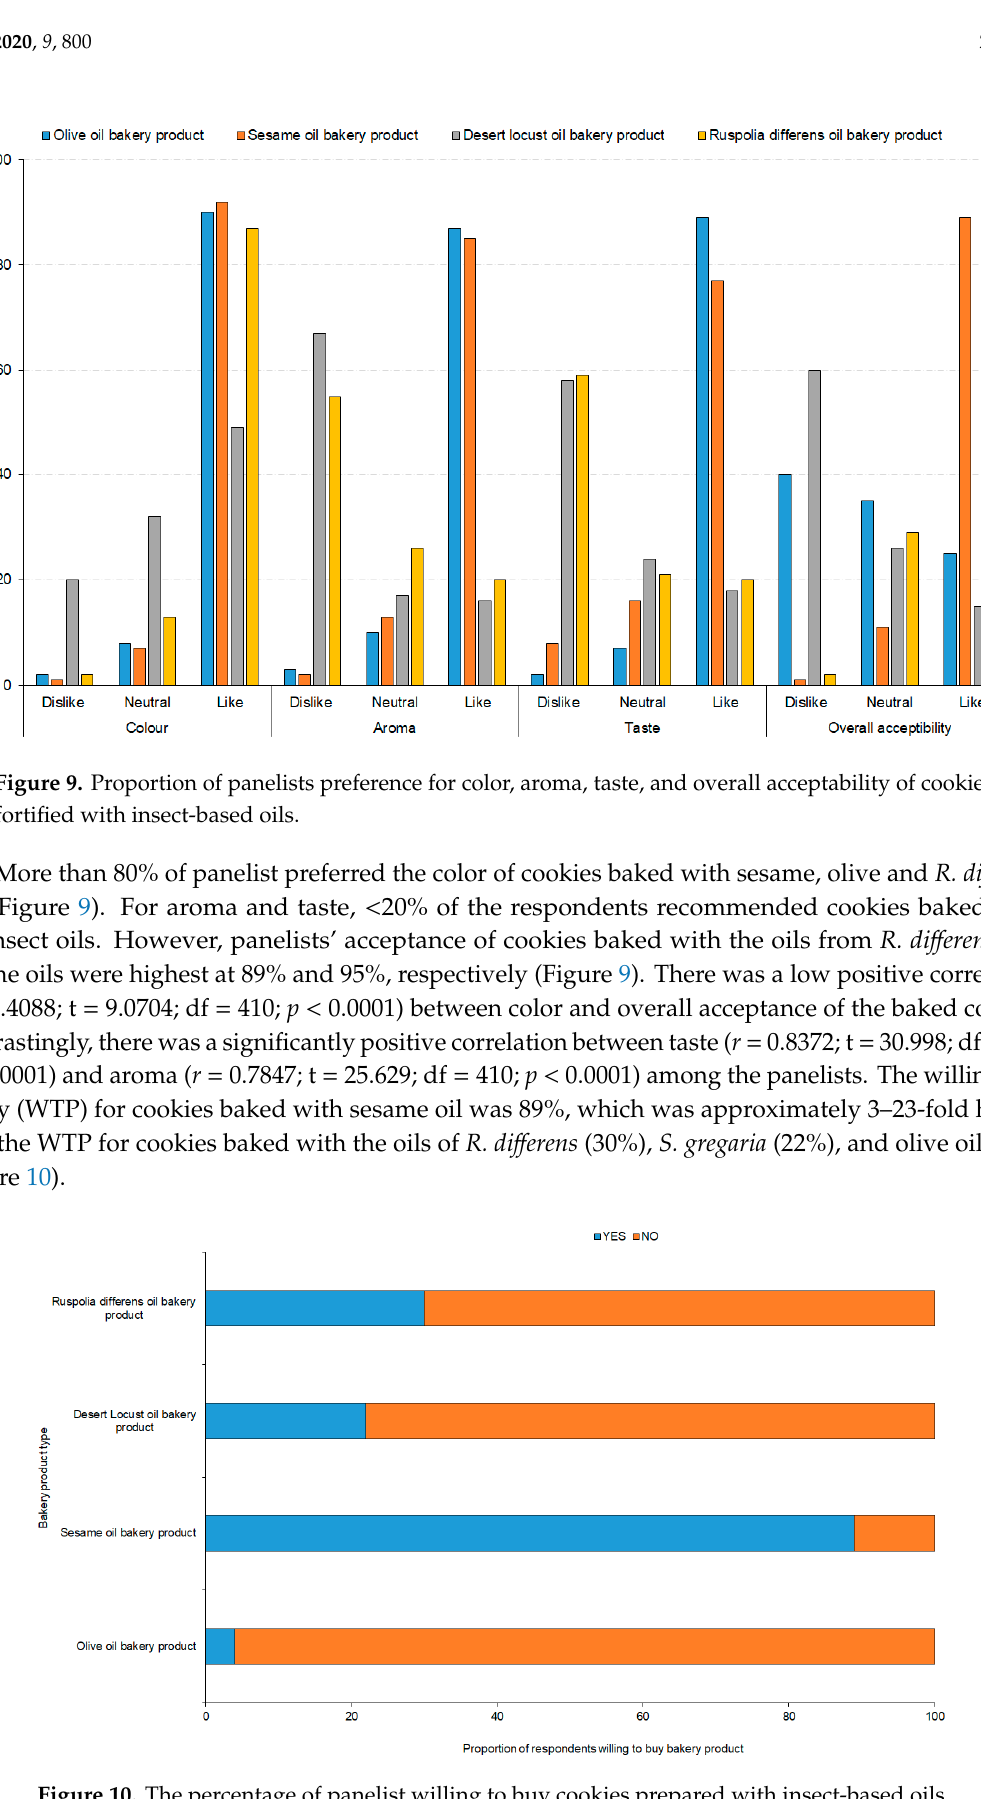
Figure 10. The percentage of panelist willing to buy cookies prepared with insect-based oils.